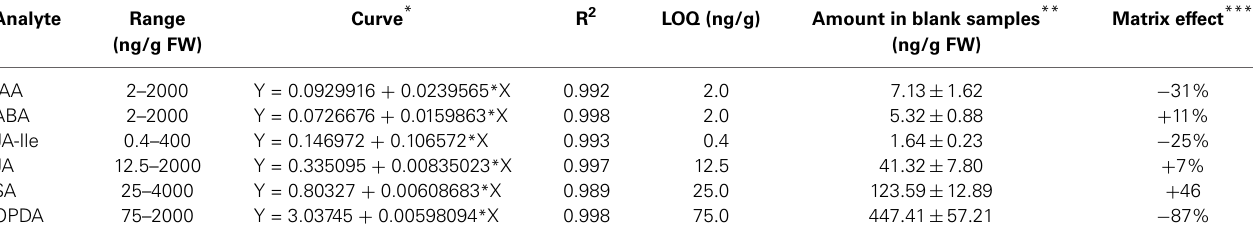
Table 2 | Parameters of calibration curve for each phytohormone: curve range, regression, weighting, correlation coefficient limit of quantification (LOQ) and amount of each phytohormone present in blank (untreated) Arabidopsis thaliana samples.